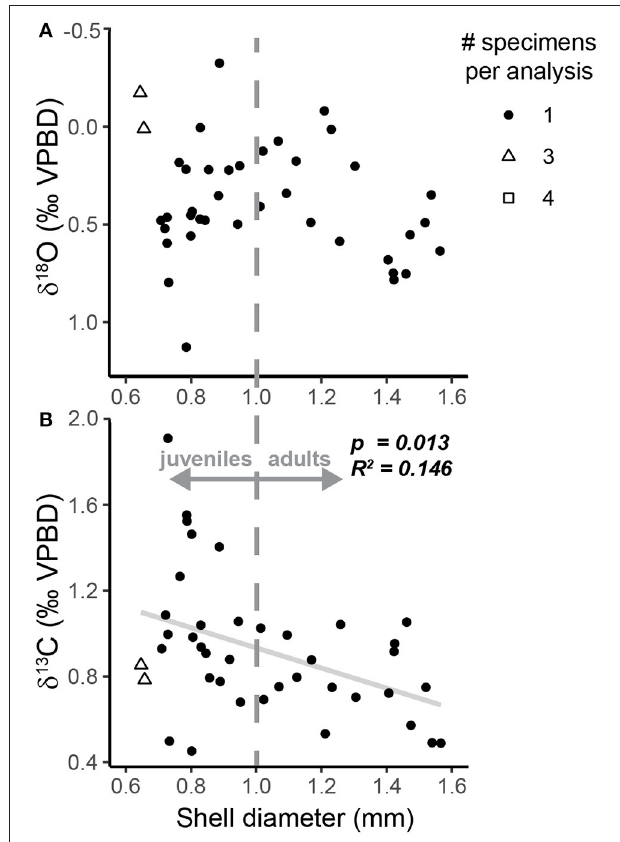
FIGURE 4 | Scatter plots of H. inflatus shell diameter relative to the (A) δ 18 O and (B) δ 13 C of shells from the sediment trap. Following convention, the δ 18 O axis is inverted. The shape of the point represents the number of specimens pooled per isotopic analysis (see key in figure). The gray dashed line represents the break between juvenile and adult pteropod shells following the work of Lalli and Wells (1978) . The relationship between δ 18 O and shell diameter is not significant ( p = 0.068, R 2 = 0.081). The relationship between δ 13 C and shell diameter is significant ( p = 0.013, R 2 = 0.146; trendline plotted in gray solid line), and δ 13 C measurements of adult shells ( > 1.0mm) are significantly less variable ( F = 3.60, p = 0.009) than those in juvenile shells ( <